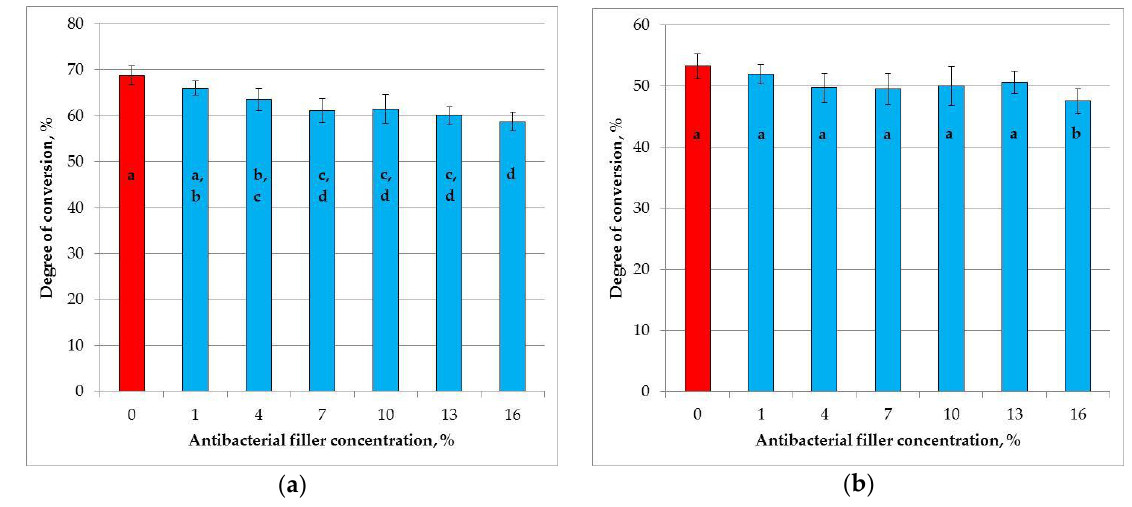
Figure 7. Mean degree of conversion values with standard deviations at the top ( a ); and at the bottom ( b ) of the samples, different lowercase letters show significantly different results at the p < 0.05 level.